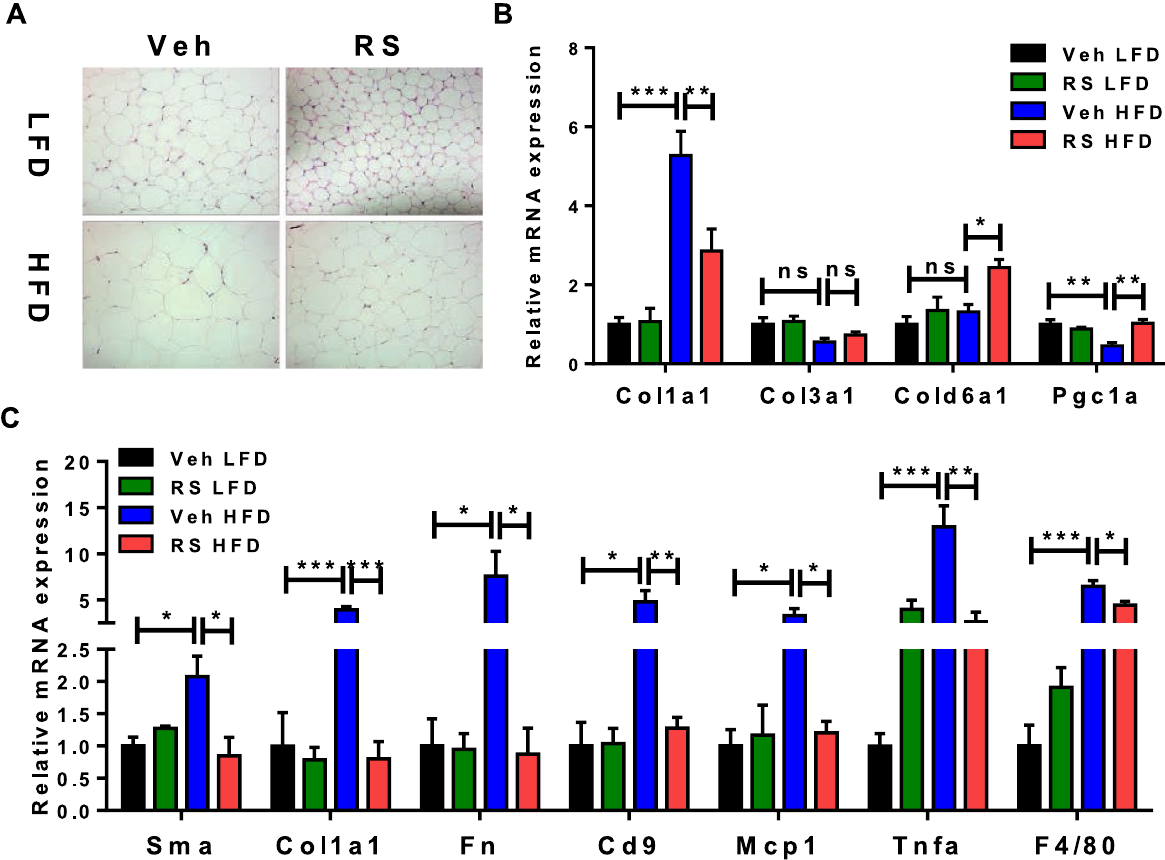
Figure 4. Roscovitine suppresses expression of inflammatory and fibrosis genes in eWAT. Analysis of eWAT in 19–20 weeks LFD and HFD fed male mice treated for last 6 weeks with roscovitine or vehicle. ( A ) Representative pictures of H&E-stained epididymal adipose tissue (eWAT) cross sections. ( B ) mRNA expression level of collagens subtype genes in mature adipocytes of eWAT (n = 5 / group). ( C ) mRNA expression level of fibrosis and inflamatory genes in the stromal vascular fraction of eWAT (n = 5 / group). Data were analyzed and illustrated using GraphPad Prism 6.0 software (GraphPad, https:// www. graph pad. com). All values are expressed as means ± SEM; *p < 0.05, **p < 0.01, and ***p <